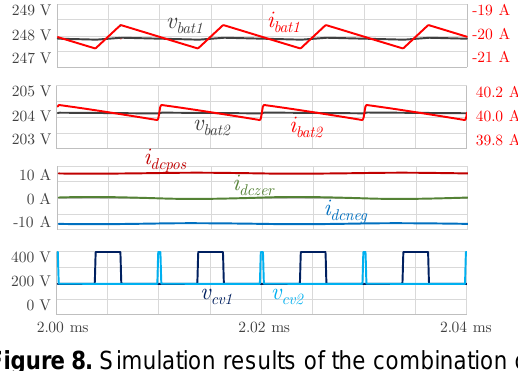
presenting a null average value.